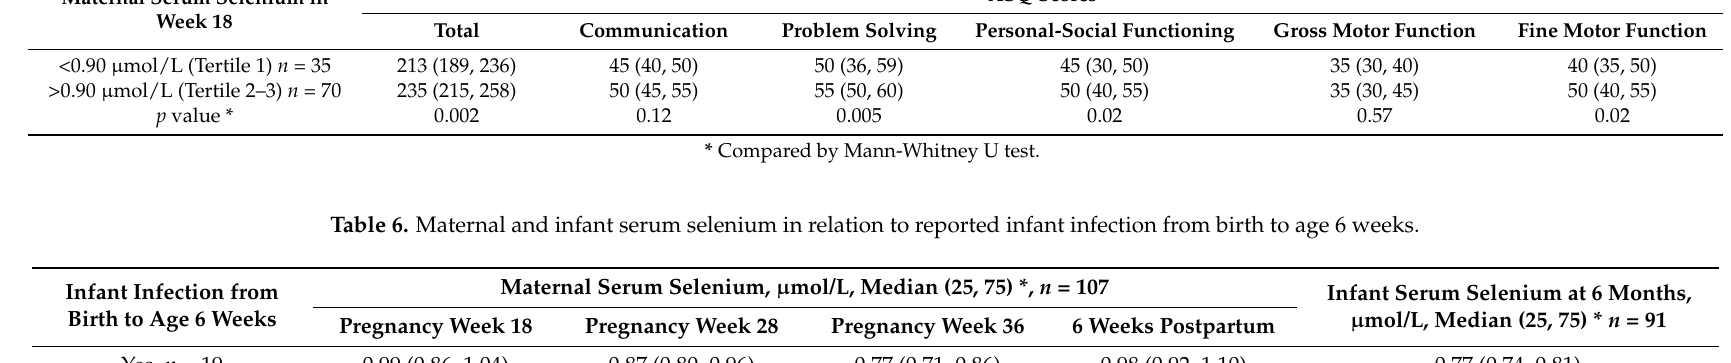
Table 5. Ages and Stages Questionnaire (ASQ) scores for the infants at 6 months in relation to maternal serum selenium levels in pregnancy week 18. Maternal Serum Selenium in Week 18